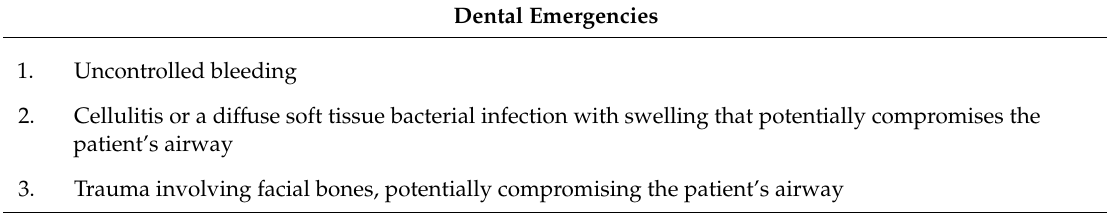
Table 4. Modified dental emergency by American Dental Association